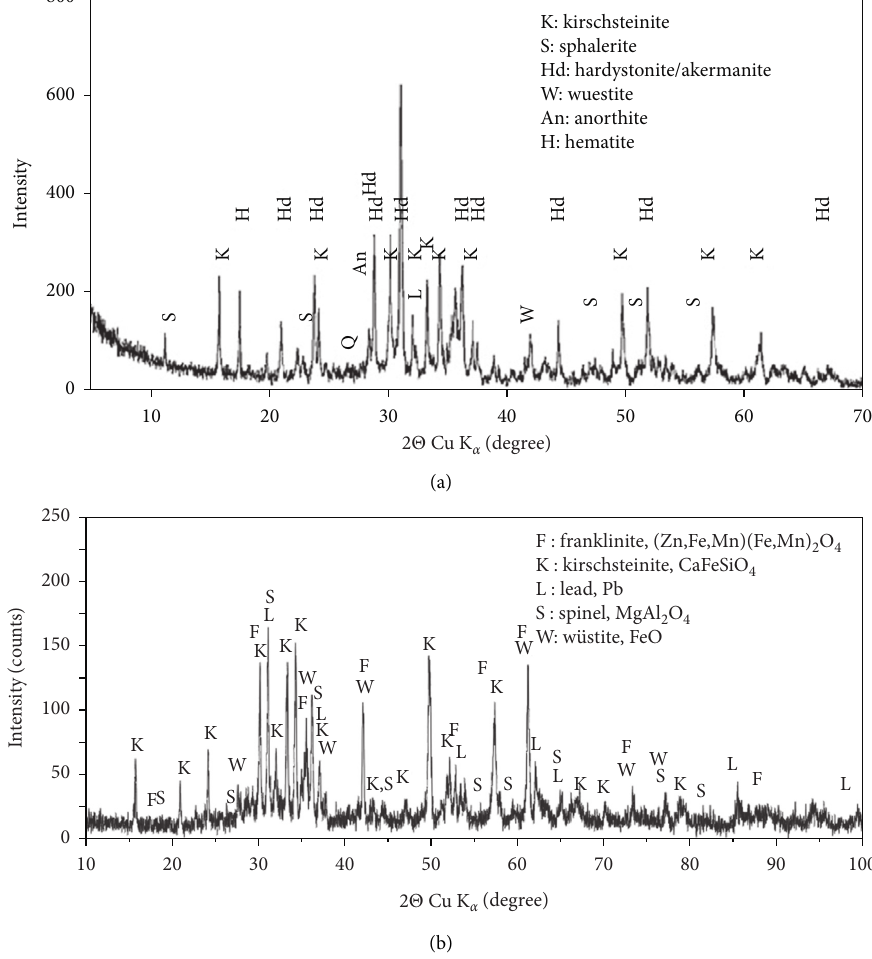
Figure 7: XRD of lead-zinc slag with high percentage of crystal phases. (a) Lead-zinc slag from Belgium [120]. (b) Lead-zinc slag from Brazil